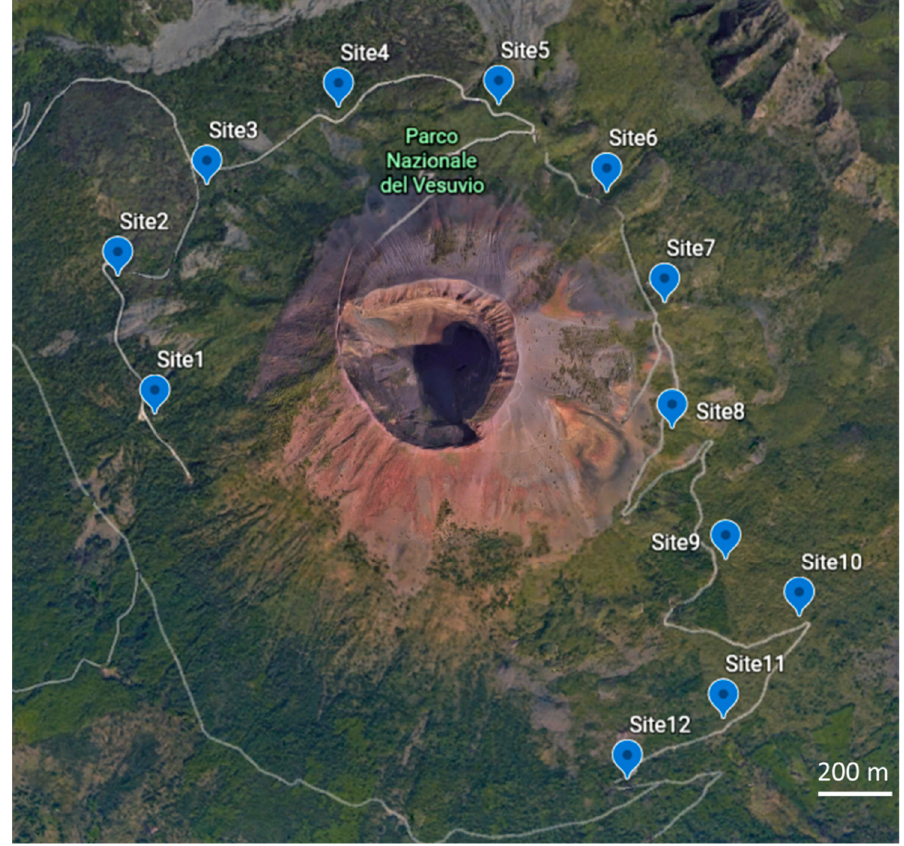
Figure 1. Map of the sampling field points (blue points) inside the Vesuvius National Park.